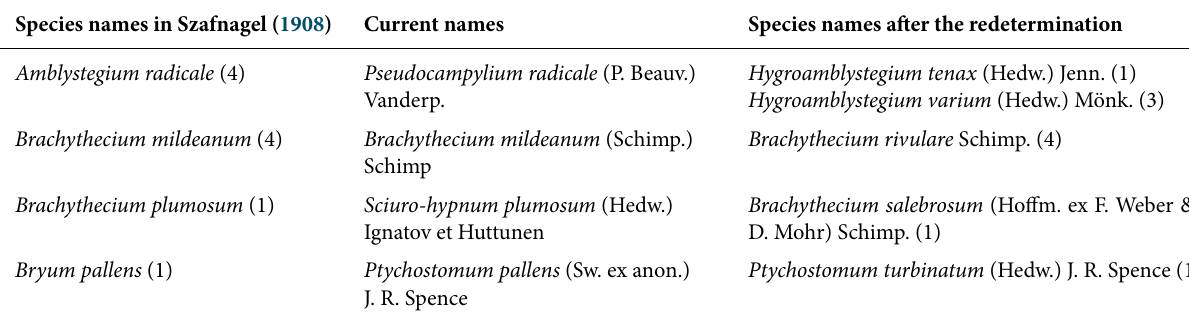
Table 2 Species listed by Szafnagel (1908) that are not confirmed following the redetermination of the specimens in his collection. Species names in Szafnagel